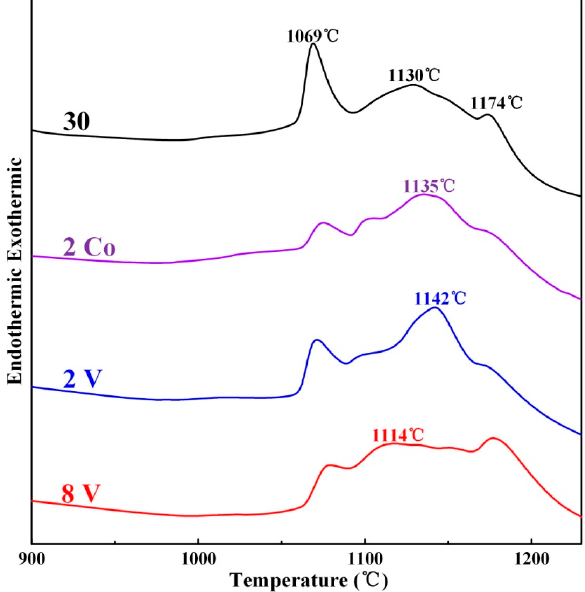
Figure 8. Differential thermal analysis (DTA) curves of different contents of Co/V in Ni–Ti–B 4 C–BN systems.